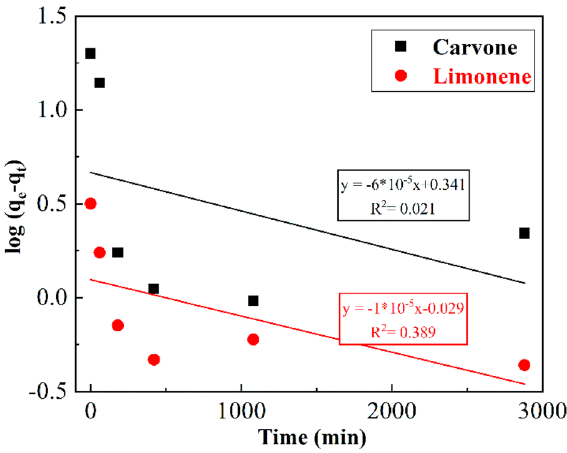
Figure 6. Pseudo-first-order kinetic model of Carvone and Limonene adsorption on purified montmorillonite.